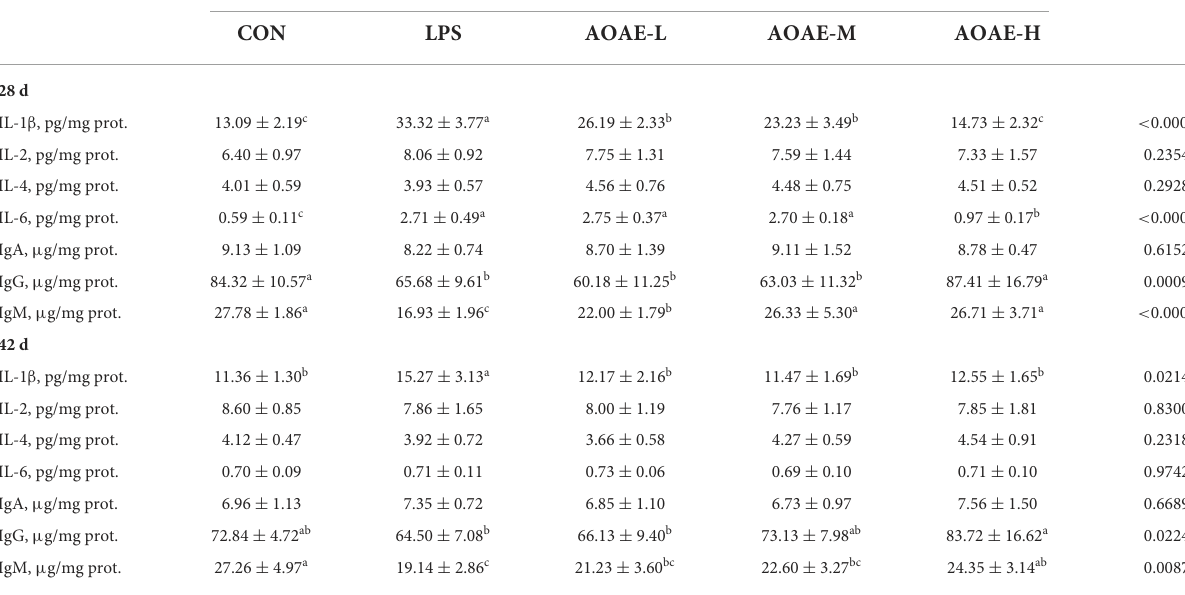
TABLE 7 Effect of AOAE on splenic cytokines and immunoglobulins in broilers challenged with LPS. Items Treatments P -value CON LPS AOAE-L AOAE-M AOAE-H 28